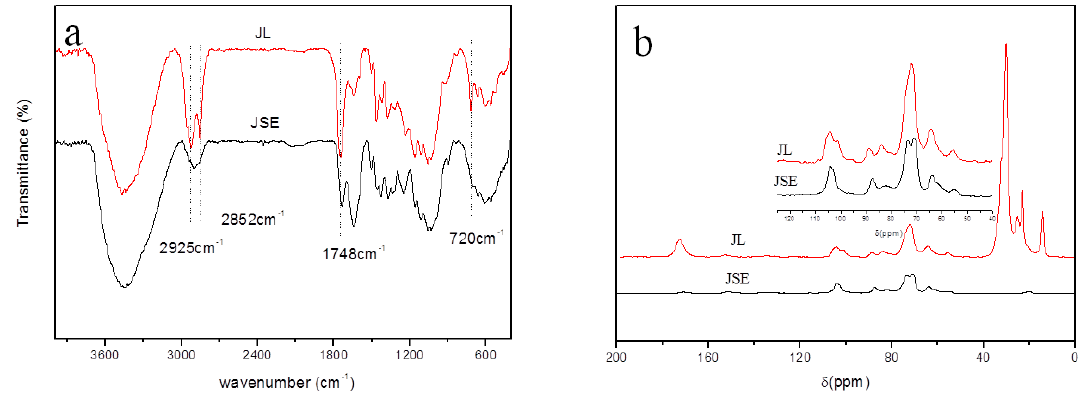
Figure 3. FTIR ( a ) and 13 C NMR ( b ) spectra of pretreated jute fibers (JSE) and JSE laurate (JL).